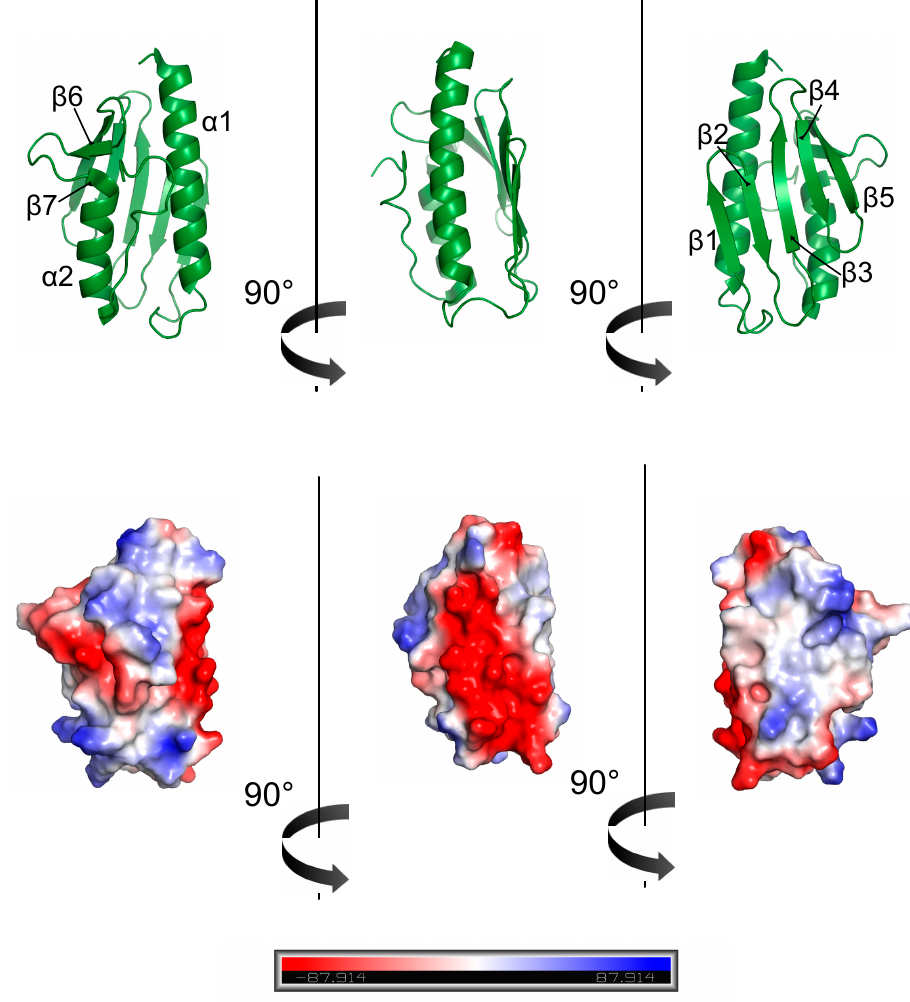
Figure 2. Human frataxin structure (PDB 1EKG) (top) and electrostatic surface (bottom). Helices α 1 and α 2 are roughly parallel and secured by hydrophobic and aromatic residues (in human frataxin, L106, F110, and L113, and L186, L190 and L194, respectively). The spatial orientation is also stabilized by the interactions between hydrophobic amino acids on the β -sheet surface and additionally by the C-terminal tail (in human frataxin, T196, L198, and L200) [85,86,88–90]. As for human frataxin, the N-terminal tail of the yeast ortholog (Yfh1) is flexible and unfolded [6,93]. On the other hand, bacterial CyaY lacks any appreciable residues in the N-terminal, compared to α 1 [7]. The three orthologues have a C-terminal tail with different lengths, without elements of a secondary structure [7,94] and with a higher mobility compared to the rest of the molecule, as confirmed by the smaller than average T 1 /T 2 and small or negative NOE values [95], in agreement with larger rmsd of the solution bundle in these regions [89]. The strong structural similarity between the three frataxin orthologs corresponds to the high degree of conservation in the amino acid sequence [5] (Figure 3).